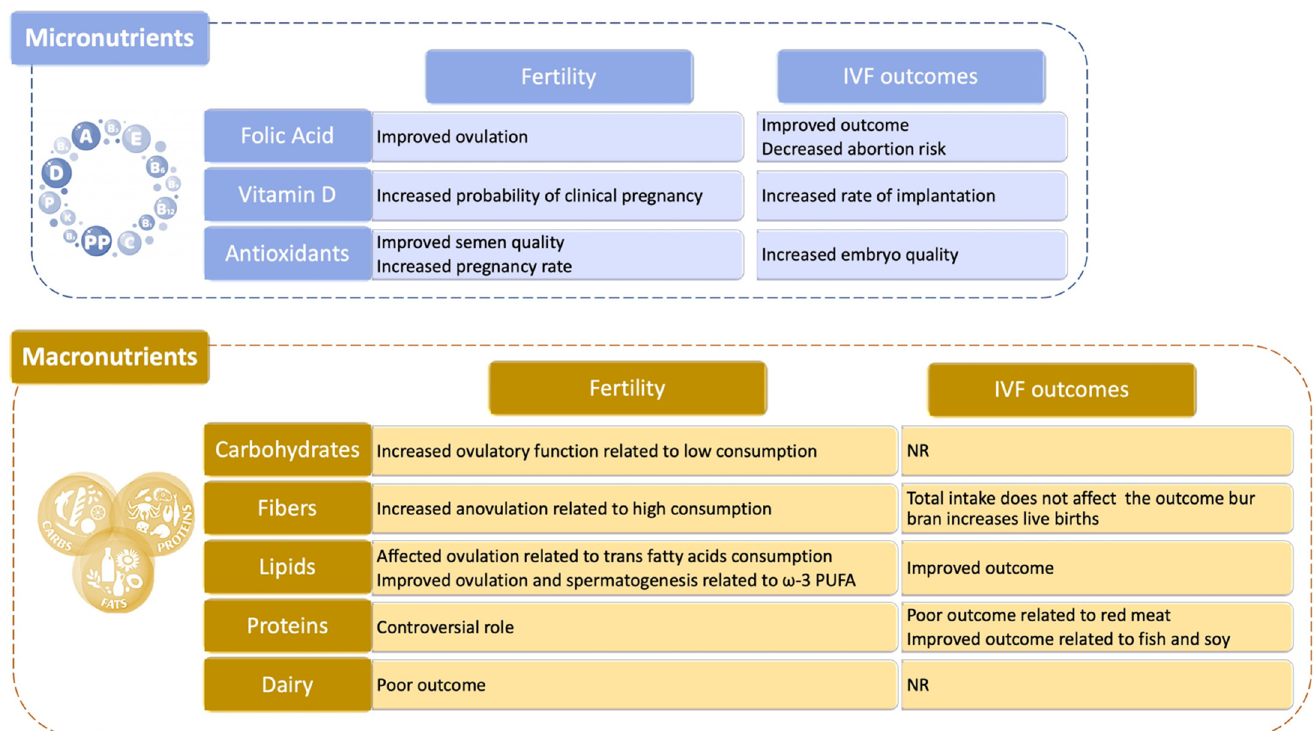
Figure 4. Role of nutrition and dietary habits on human reproduction. Both micro- and macronutients are able to influence different aspects of male and/or female infertility and to influence also the outcome of in vitro fertilization (IVF) proce-